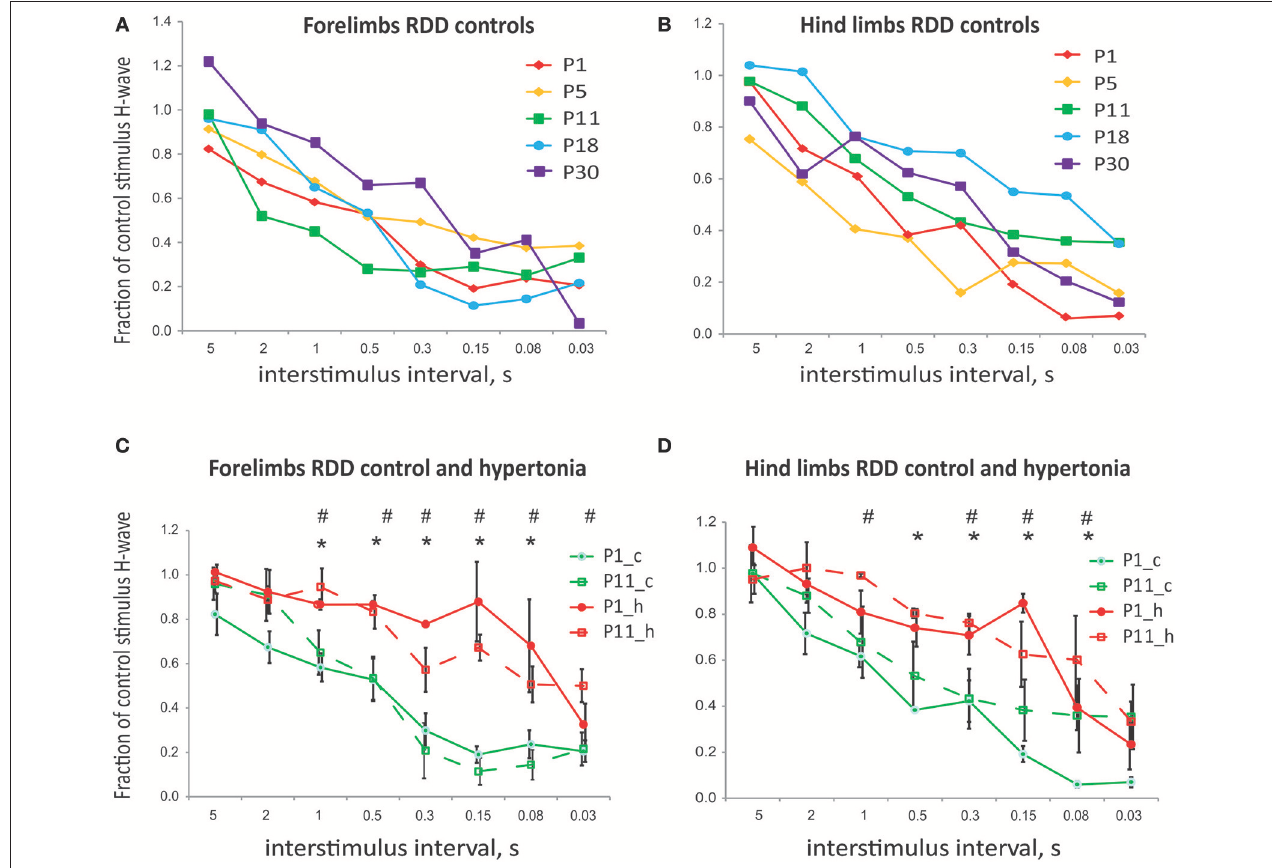
FIGURE 4 | (A) Rate dependent depression of H-reflex in normal development and after antenatal H-I. No difference in rate dependent depression of H-reflex with development. (B) No difference in RDD between forelimbs and hind limbs for corresponding ages. (C) Reduction in RDD in hypertonic kits after H-I in forelimbs at P1 and P1. (D) Reduction in RDD in hypertonic kits after H-I in hind limbs at P1 and P1. * p < 0.05 for P1, # p < 0.05 for